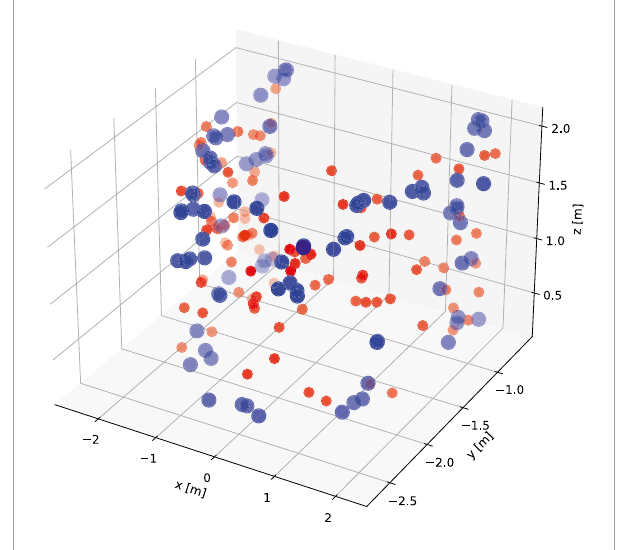
FIGURE 1 Targets from training set (blue) and perceptual test set (red) visualized in 3D space.